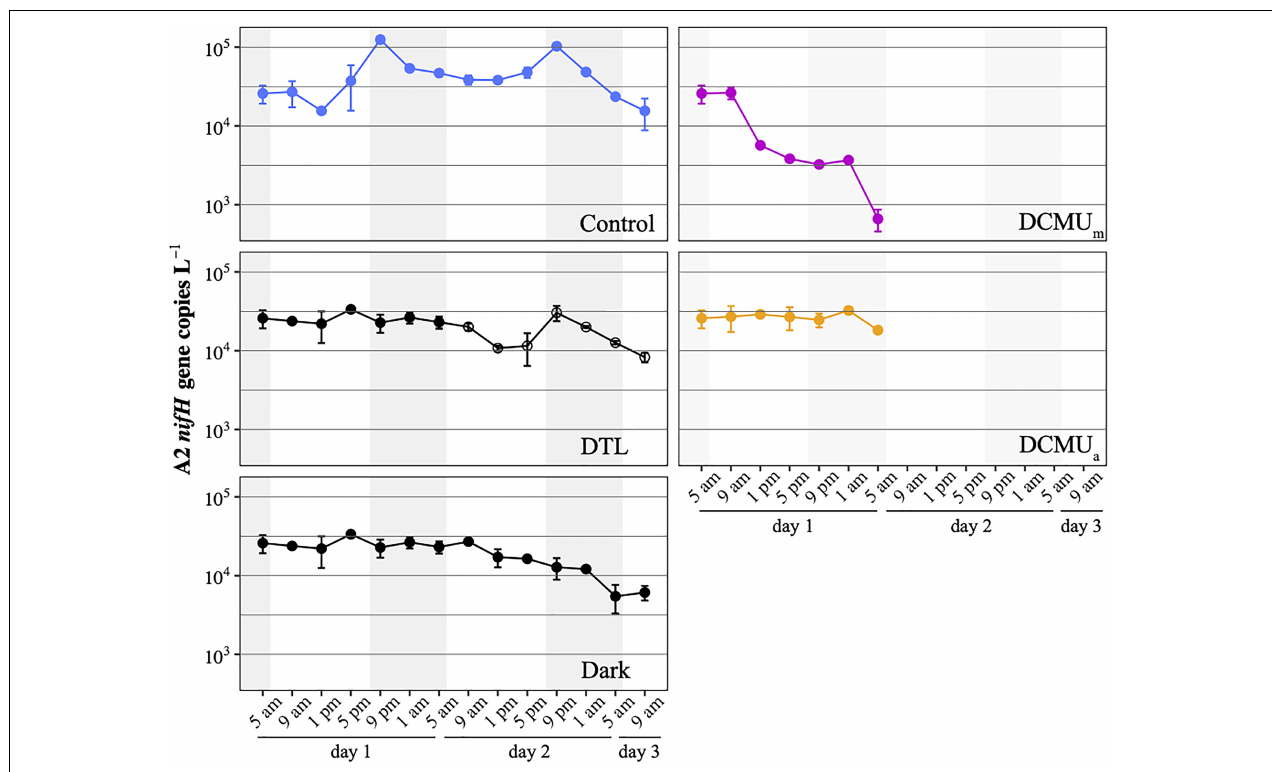
FIGURE 2 | UCYN-A2 nifH gene abundances in control (blue), DTL (black and open circles), Dark (black), DCMU m (purple), and DCMU a (orange) incubations. Mean ± SD from duplicate incubations are shown at each time point. DCMU was spiked at 5 a.m. for the DCMU m condition and at 1 p.m. for the DCMU a condition. Note that the DTL condition data start at 9 a.m. on the second day of the experiment, and values plotted before that are identical to those from the Dark